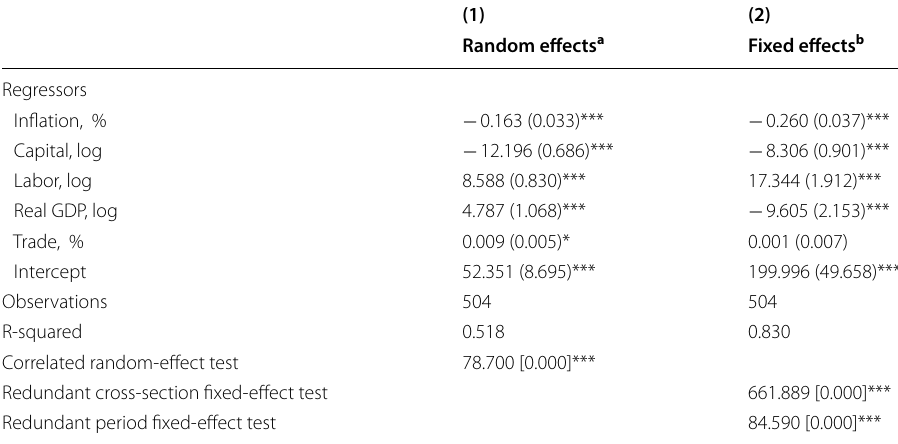
Table 3 Fixed-effect versus random-effect regression results (the dependent variable is the natural log of